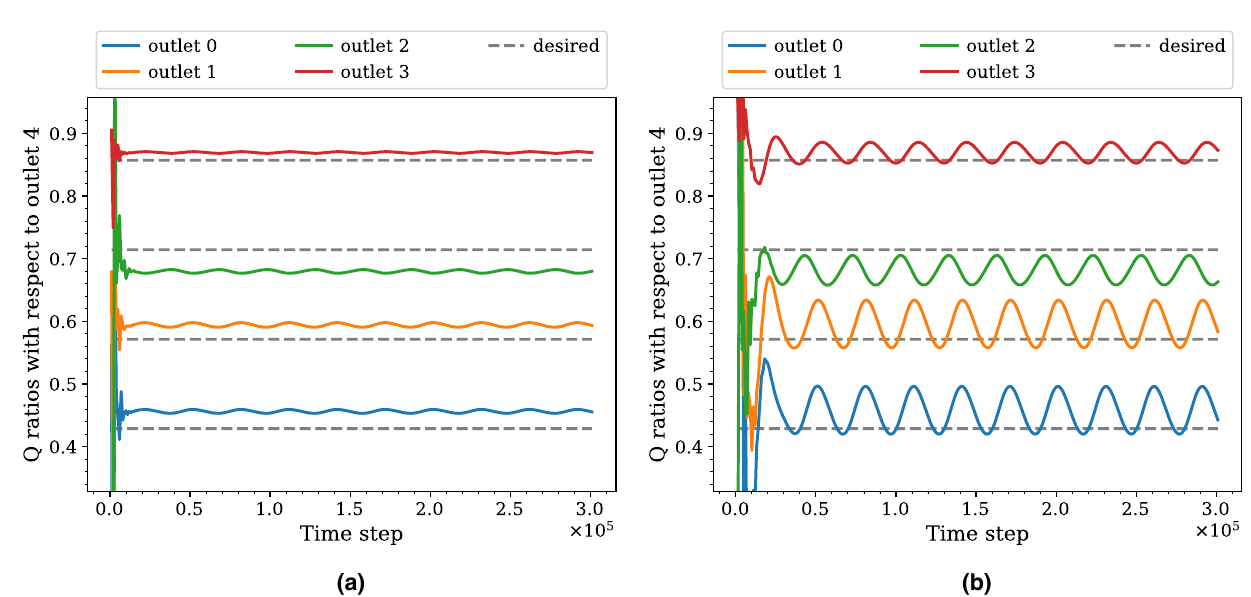
Figure 5. Time series of the flow rate ( Q ) ratios for the outlets in simulations with different γ RC but the same γ R . The results are obtained from the simulations on the fine grid of the five-outlets domain using (a) γ RC 8 with the same γ R 4 . The outlet 4 is used as the reference when computing the ratios. We and (b) γ RC = = observe a longer transient period and stronger fluctuations in (b) than (a)